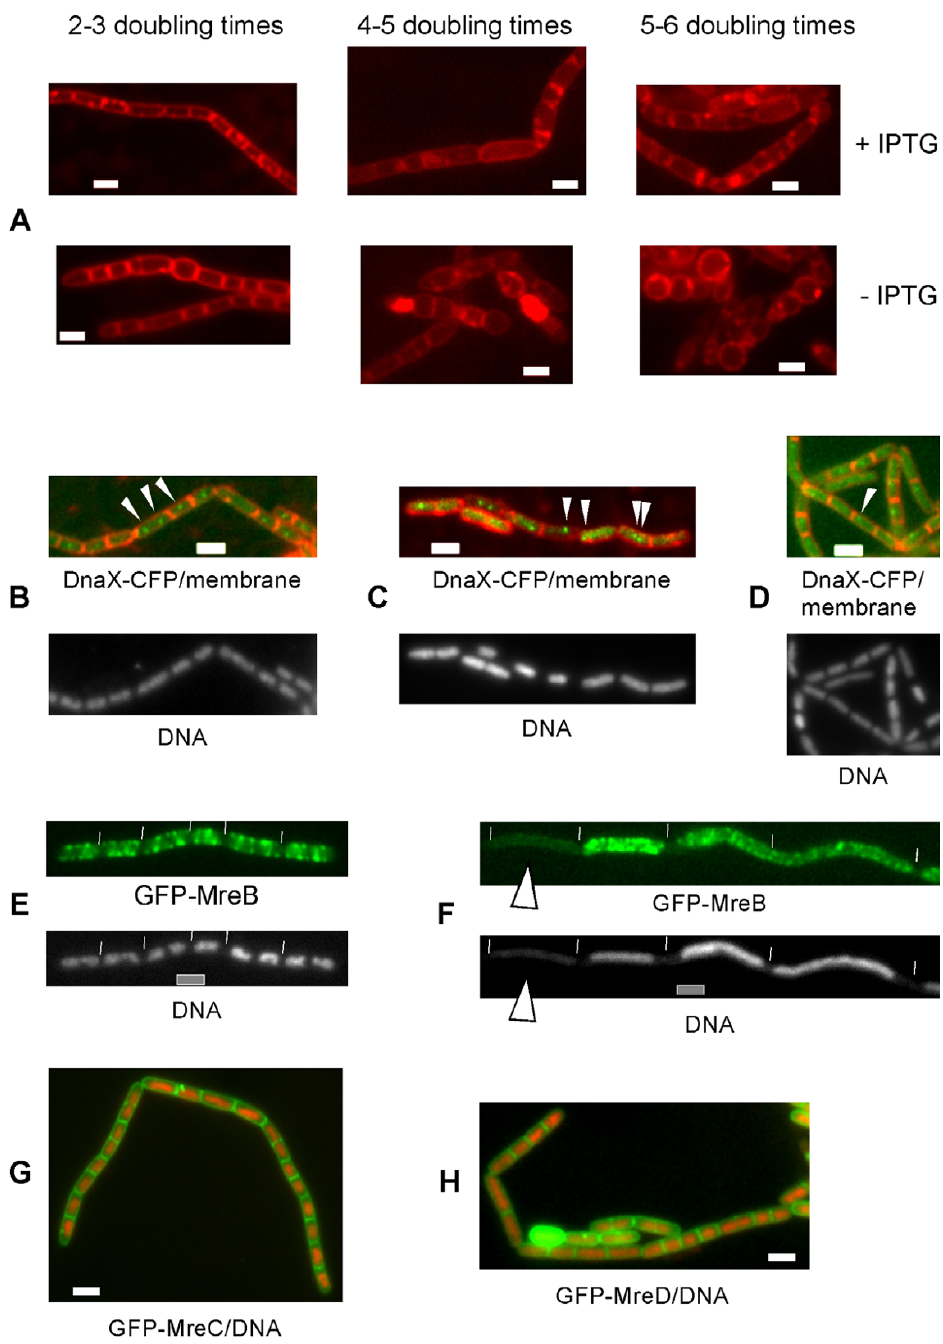
Figure 2 Depletion of MreB in the presence of MreC and of MreD affects both cell shape and segregation of chromosomes, and affects localization of the replication factory. Fluorescence microscopy of exponentially growing Bacillus subtilis cells. A) MreB is depleted in the presence (+IPTG, upper panels) or in the absence (-IPTG, lower panels) of MreC and MreD, 2–3, 4–5 and 5–6 doubling times indicate the time after the onset of depletion. B) Localization of DnaX-CFP in wild type cells, or C) 2–3 doubling times after depletion of MreB, or D) 2–3 doubling times after depletion of Mbl. Arrowheads indicate the proper positioning of DnaX-CFP in wild type cells, and its abnormal loacalization during depletion of actin orthologs. E) Localization of GFP-MreB in wild type cells, or F) in smc mutant cells, G) localization of GFP-MreC, overlay of GFP-MreC (green) and DNA stain (red), H) localization of MreD, overlay of GFP-MreD (green) and DNA (red). White lines indicate ends of cells, white bars 2 µ